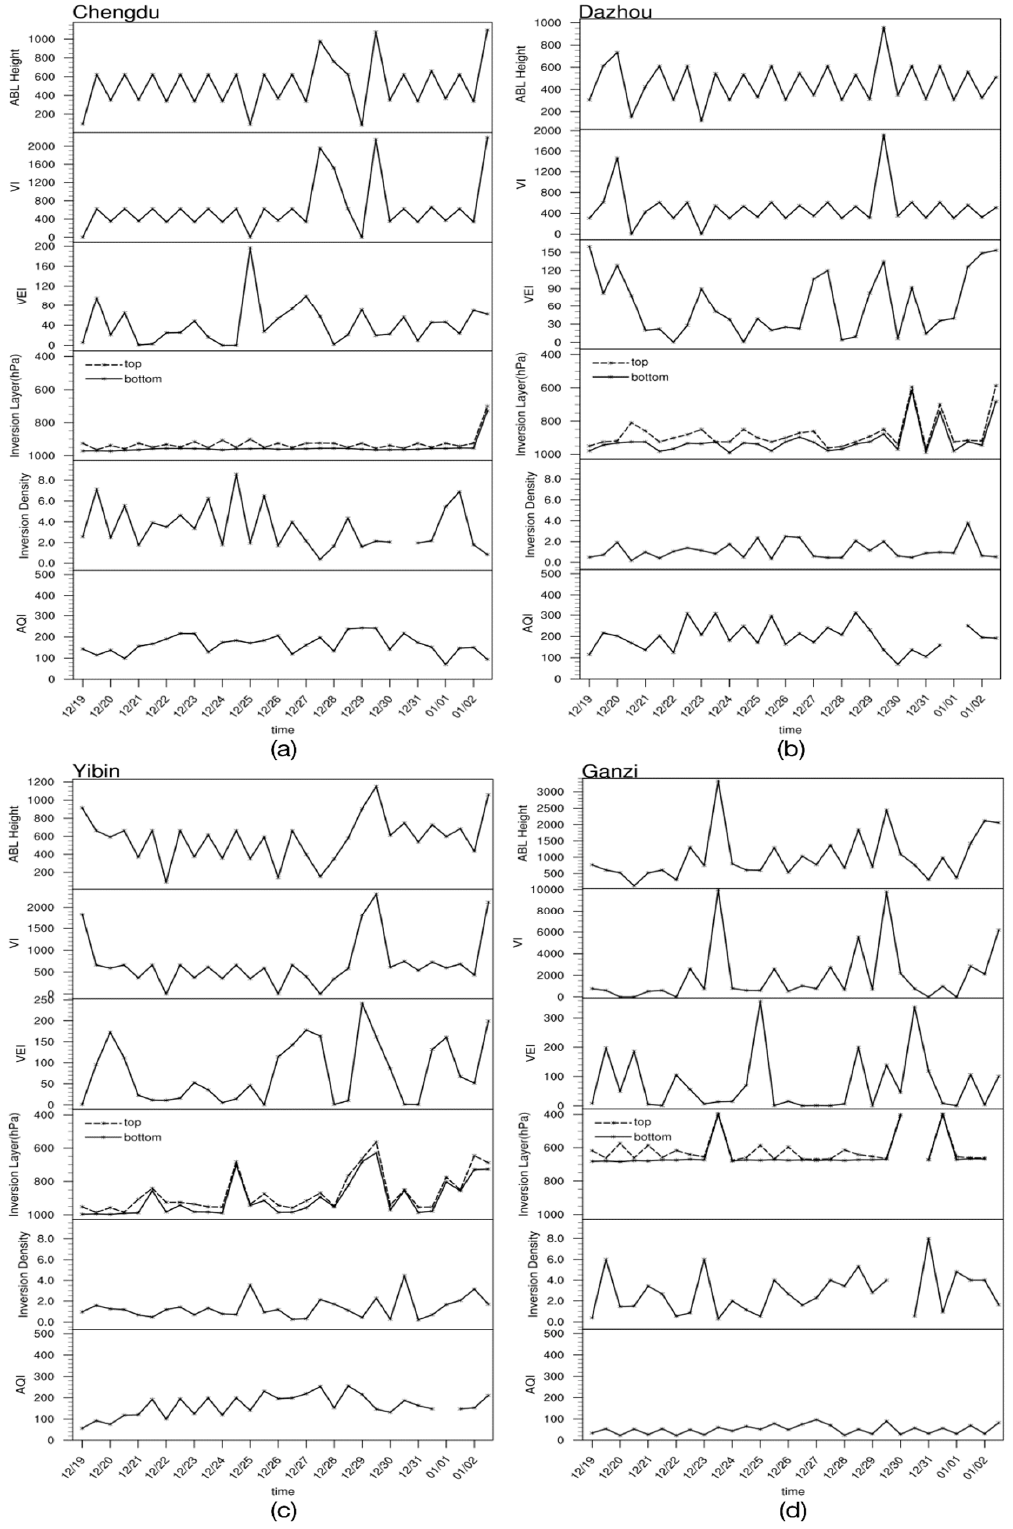
Figure 10. The time series of the boundary layer height, the ventilation index (VI), the vertical exchange index (VEI), the height of the bottom and the top of the first inversion, the inversion intensity, and the AQI (from top to bottom) in the eight chosen cities in northern Sichuan ( a ), eastern Sichuan ( b ), southern Sichuan ( c ) and western Sichuan ( d ) from 19 December 2017 to 2 January